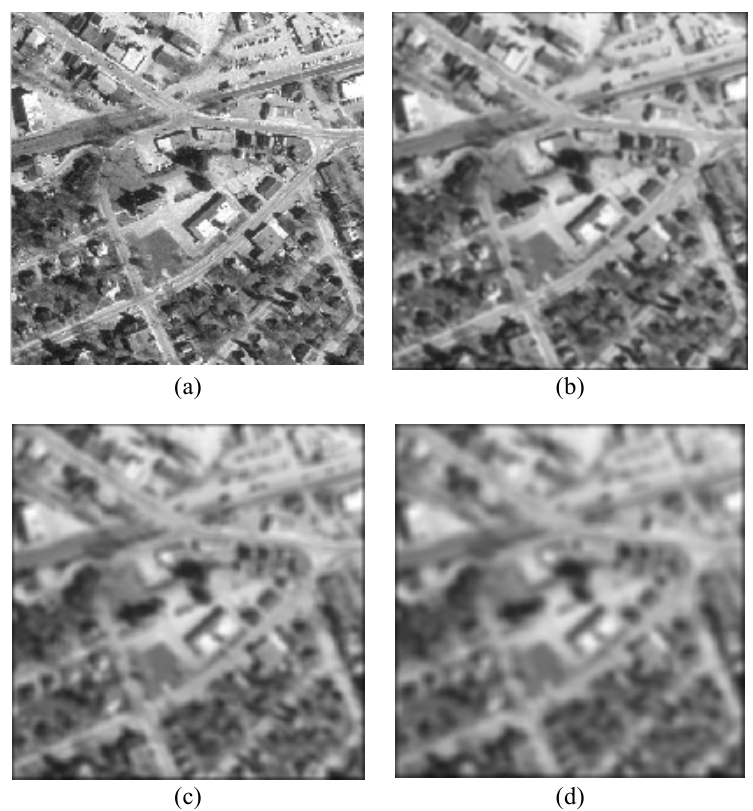
Fig. 3. Influence of the PSF size on the image. (a) Original image, (b) Degraded image with PSF